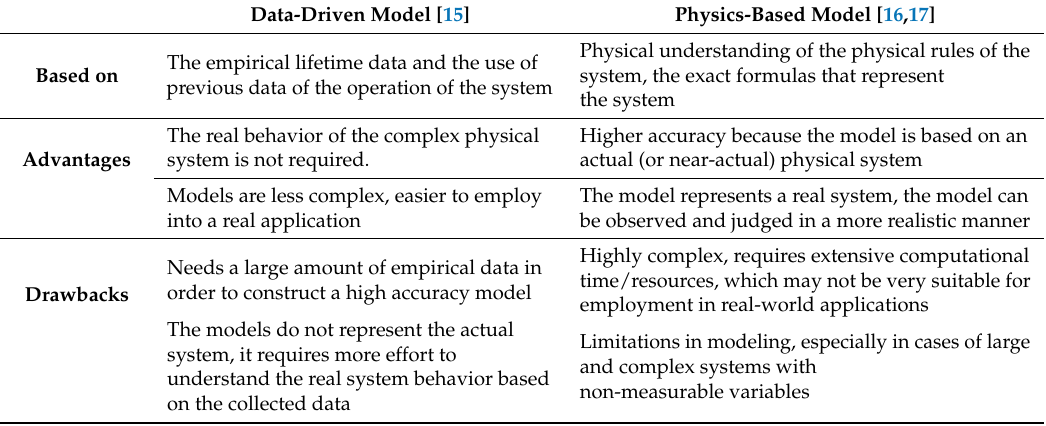
Table 1. Difference between data-driven and physics-based models for diagnostics and